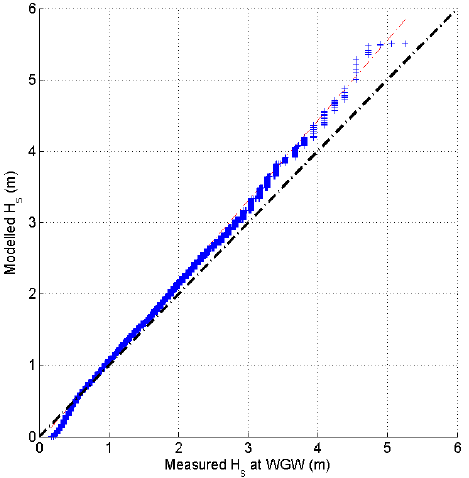
Figure 5. Empirical quantile–quantile plot of H s between measured wave data and modelled data.